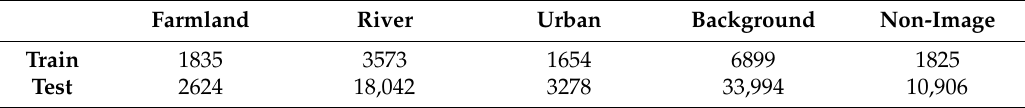
Table 1. The numbers of superpixels of five classes in the training and testing set. Farmland